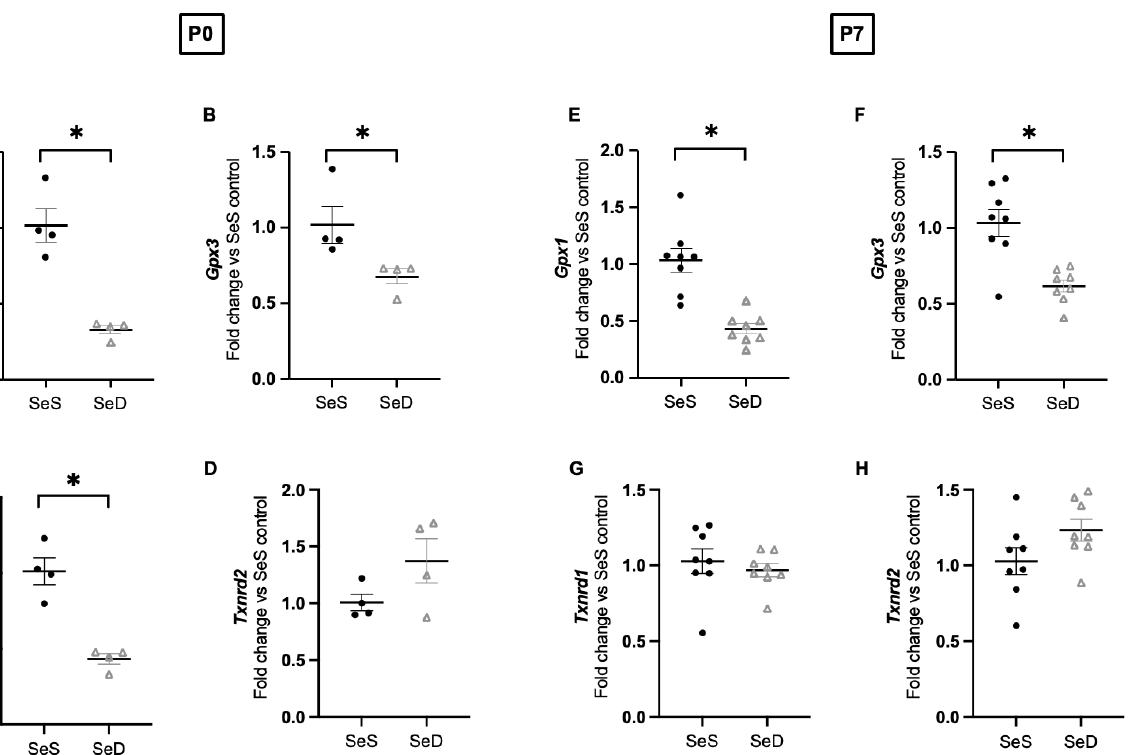
Figure 5. Se deficient lungs exhibit decreased Gpx1 and Gpx3 gene transcription at P0 and P7. C57Bl/6 mice were placed on diets that differed only in Se content, either 0.4 ppm or <0.01 ppm of sodium selenite, through pregnancy and lactation. Pulmonary organ homogenate was evaluated on day of birth (P0) and postnatal day 7 (P7). Fold change ( A ) Gpx1 , ( B ) Gpx3, ( C ) Txnrd1 , and ( D ) Txnrd2 (normalized to SeS) at P0. Fold change ( E ) Gpx1 , ( F ) Gpx3, ( G ) Txnrd1 , and ( H ) Txnrd2 are (normalized to SeS) at P7. N = 4–8 for all groups. Data presented as mean ( ± SEM), * p < 0.05 vs. SeS age matched control, by Students two-sided t -test.